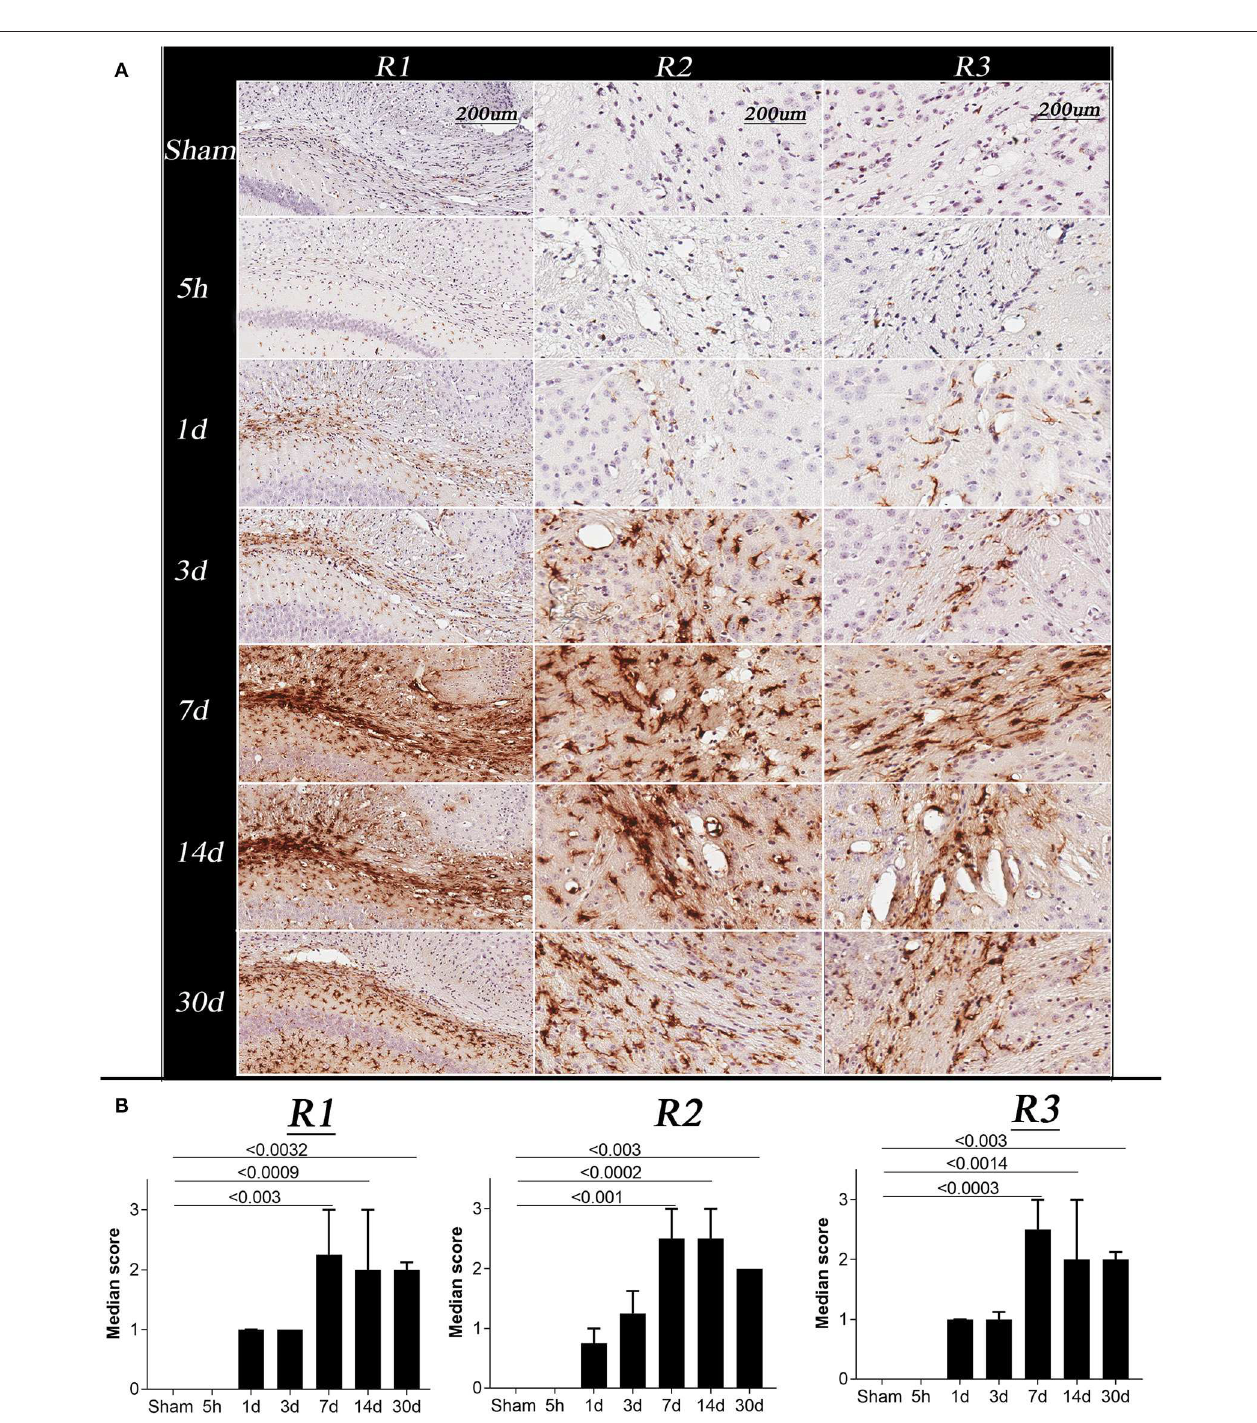
FIGURE 5 | Changes in glial fibrillary acidic protein (GFAP) immunoreactivity in sham and TBI mice at specific post-injury time points (5h, 1 day, 3, 7, 14, and 30 days). (A) R1, R2, and R3 of representative animals for the sham and TBI groups, showing changes in GFAP immunoreactivity following injury, all images were acquired at 20 × resolution; Scale bar = 200 µ m. (B) Represents the graph for the astrogliosis median score, Kruskal–Wallis tests with Dunn’s multiple comparisons post tests were performed. Median and interquartile range were plotted with corrected p -values shown on the graphs. The overall score of sham and 5h in all the regions were 0. A significant increase in GFAP immunoreactivity was observed on day 1, 3, 7, 14, and 30 in all the regions with a maximum change on day 7 post injury.